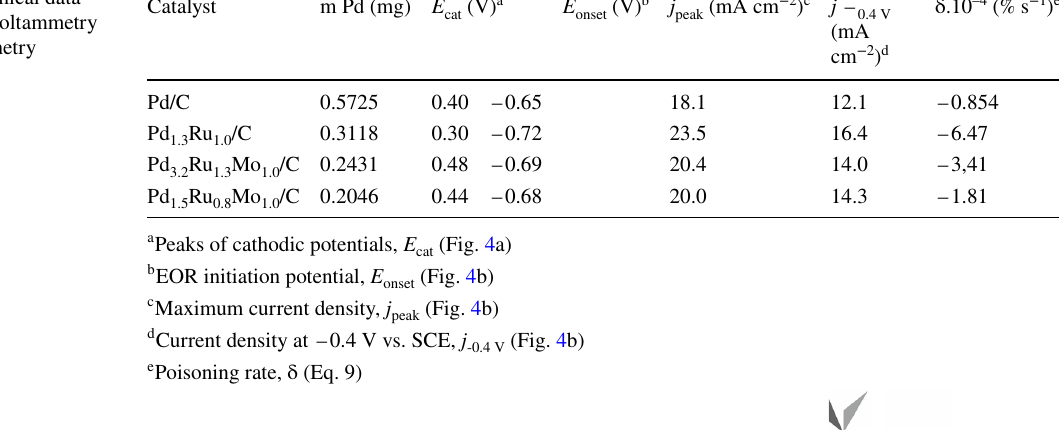
cat (Fig. 4a) onset (Fig. 4b) peak (Fig. 4b)